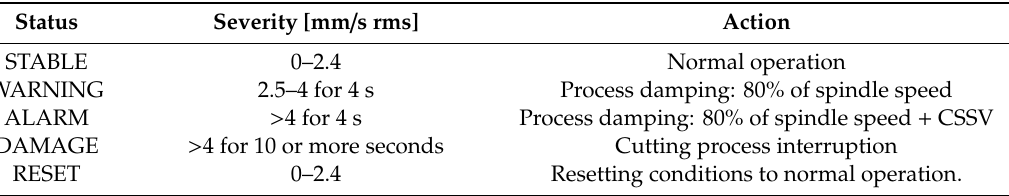
Table 3. Algorithm